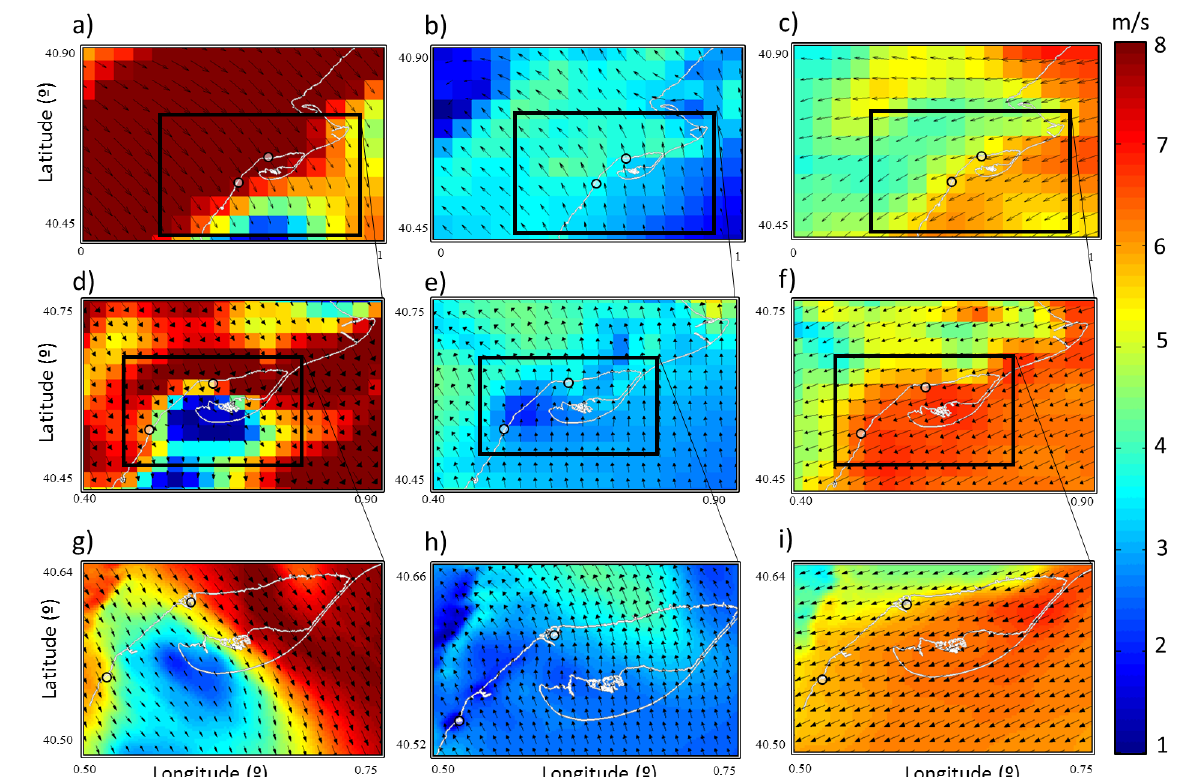
Figure 6. The three different models configurations are plotted for three snapshots of typical wind events at Alfacs Bay. (a–c) for WRF9km, (d–f) for WRF3 and (g–i) for CALMET 400m. Events represent winds from the northwest (left column panels) on 4 April 2014, sea breezes (central panels) on 6 July 2013 and northeasterly winds (right panels) on 12 March 2014. White circles indicate meteorological station locations (M-A and